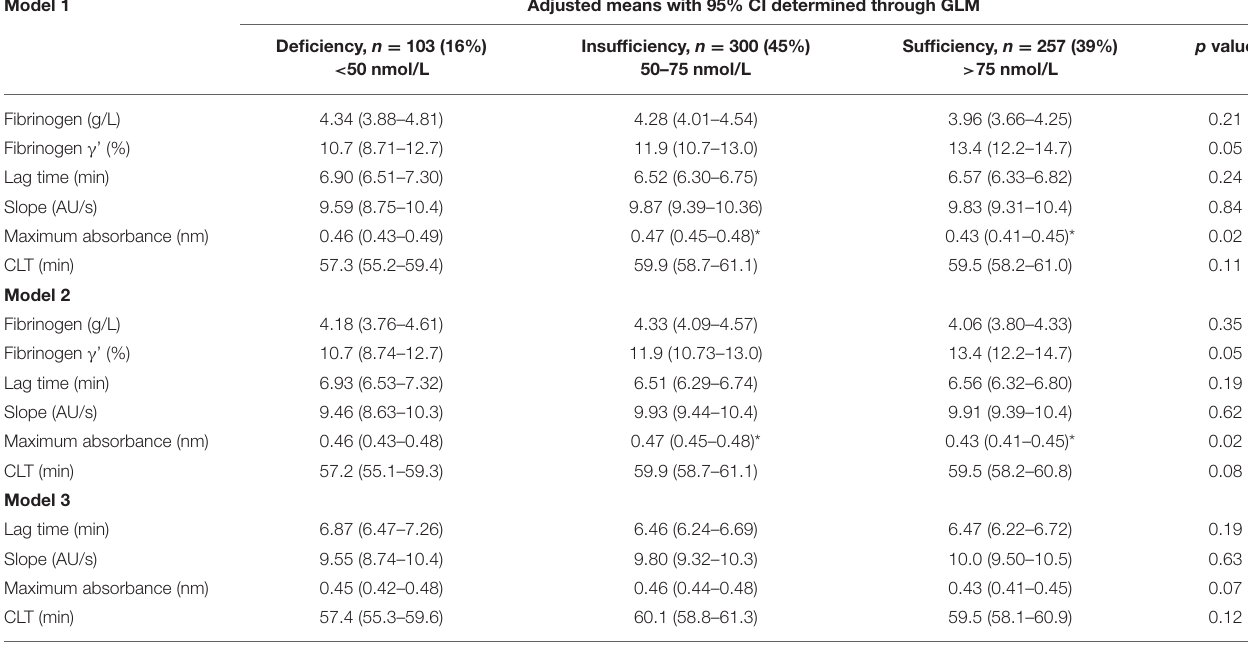
TABLE 3 | 25(OH)D status categories in relation to total and γ ’ fibrinogen as well as plasma clot properties. Model 1